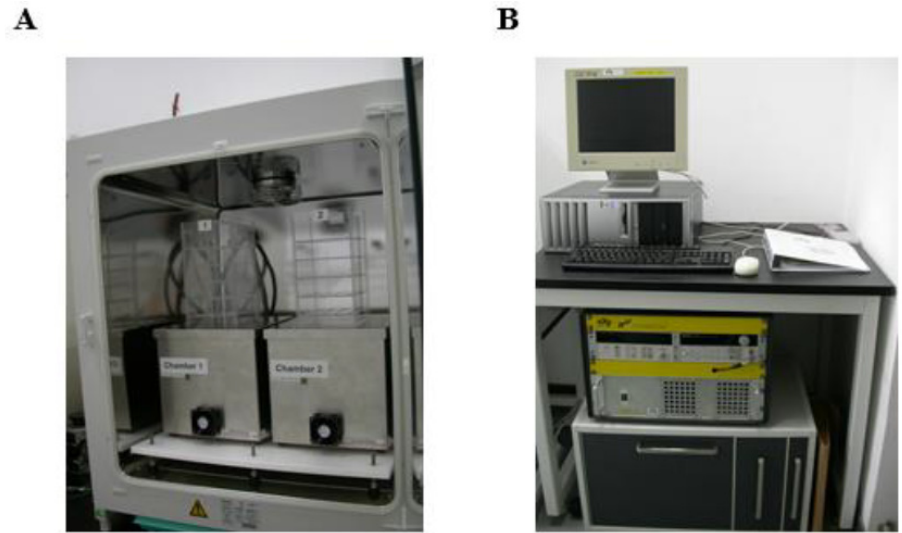
Figure 6. The 50-Hz magnetic field exposure system (sXc-ELF). It consists of two exposure chambers ( A ) and a set of control device ( B ).